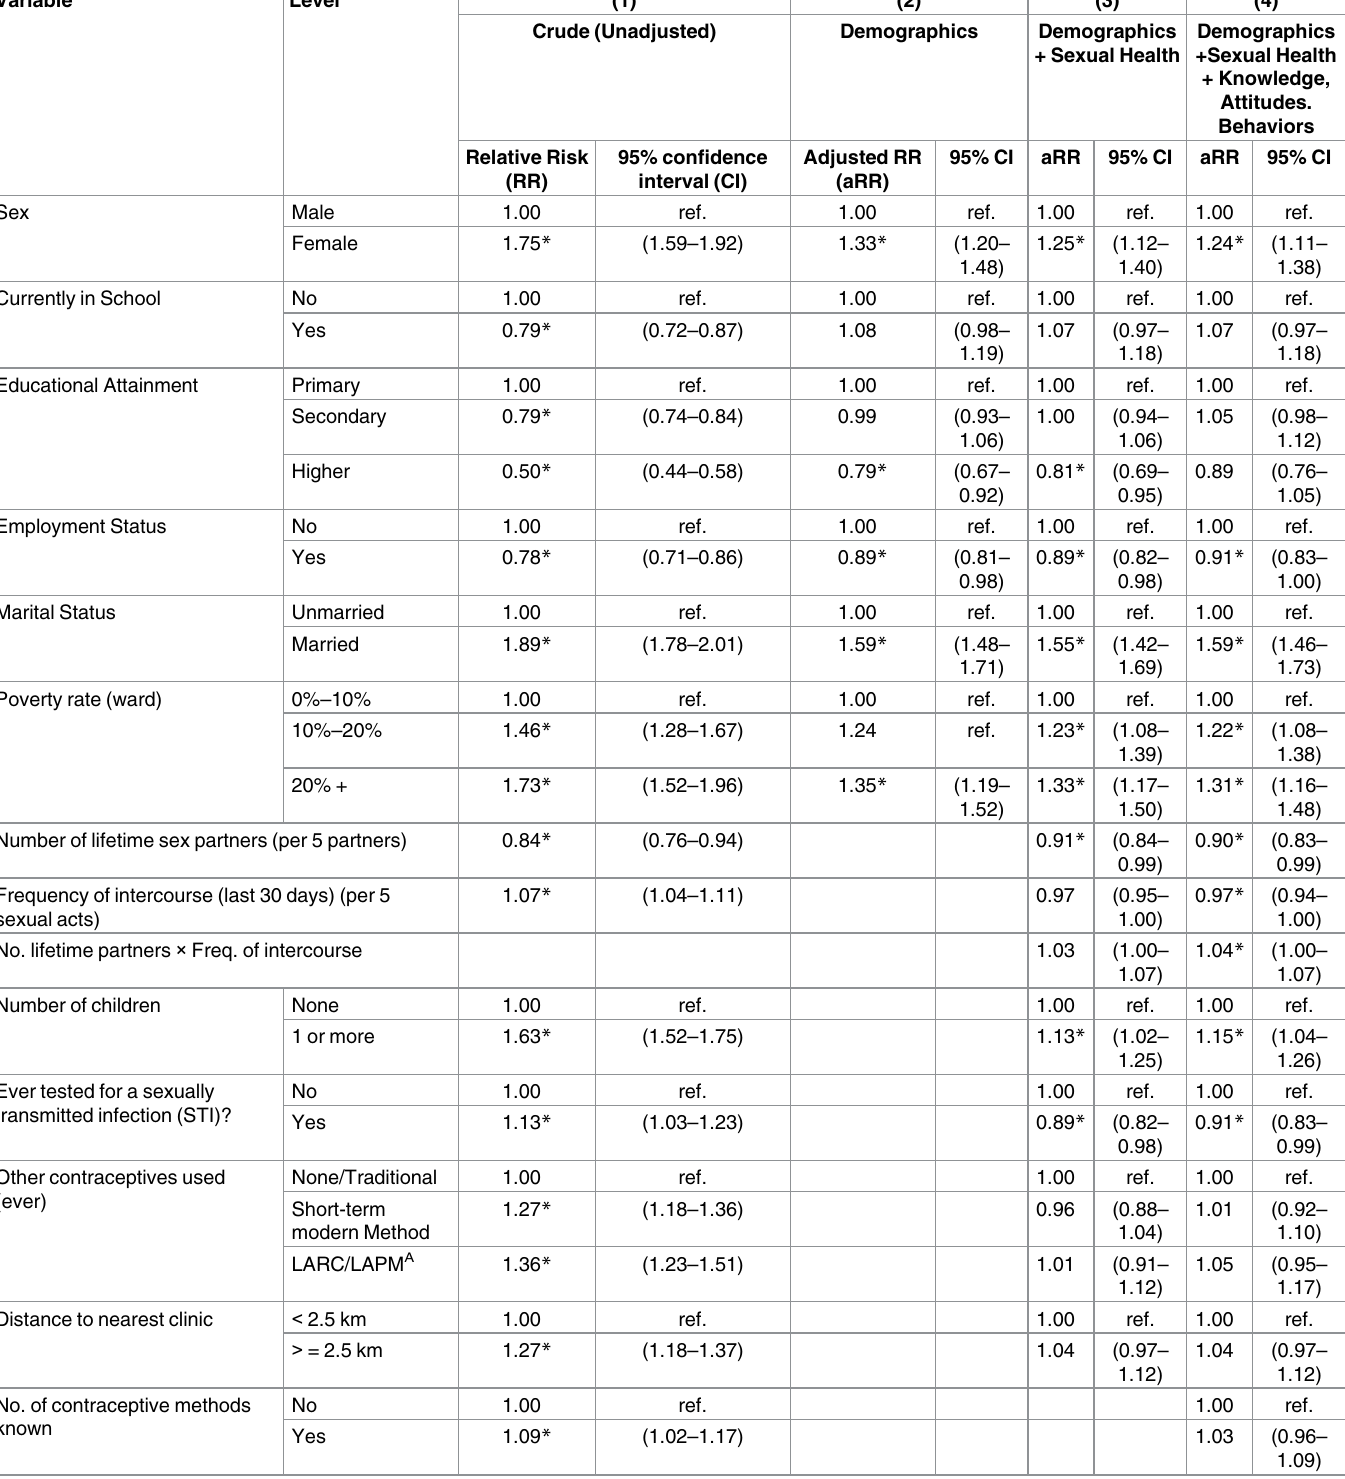
Table 3. Factors associated with non-use of a male condom at most recent sexual